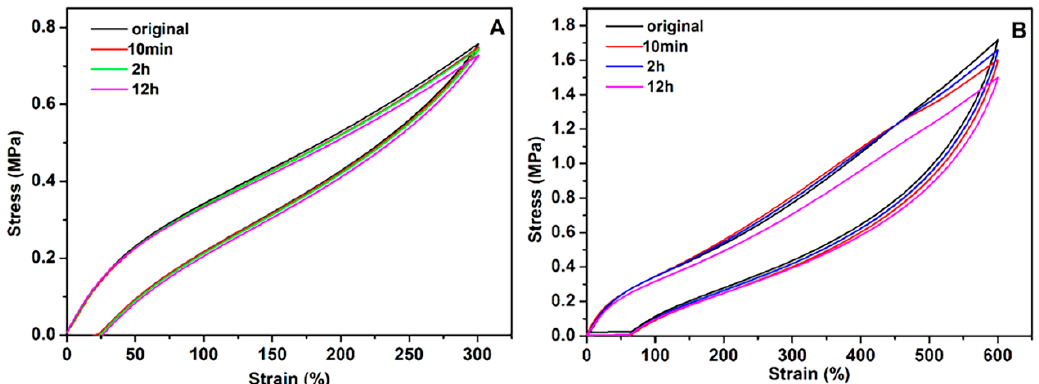
Figure 9. Tensile loading–unloading cycle curves of TA30–PU(S) hydrogel for different soaking times in distilled water: ( A ) at strain of 300%; ( B ) at strain of 600%.